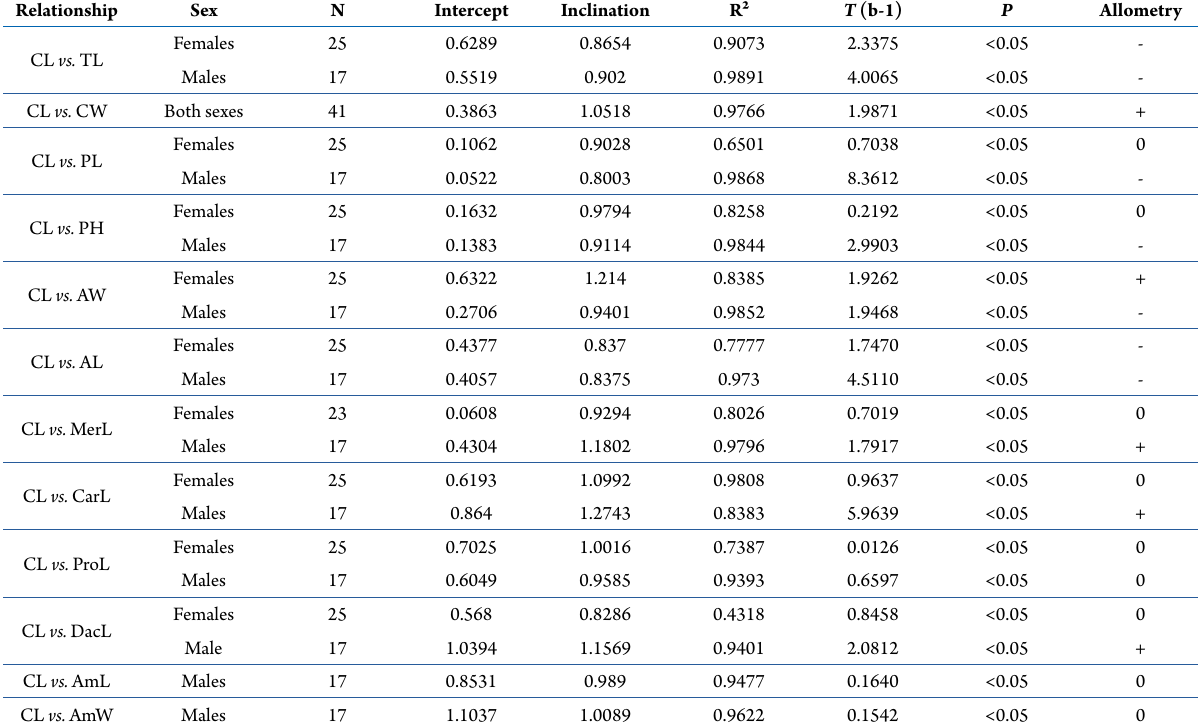
CL vs. CW CL vs. PL